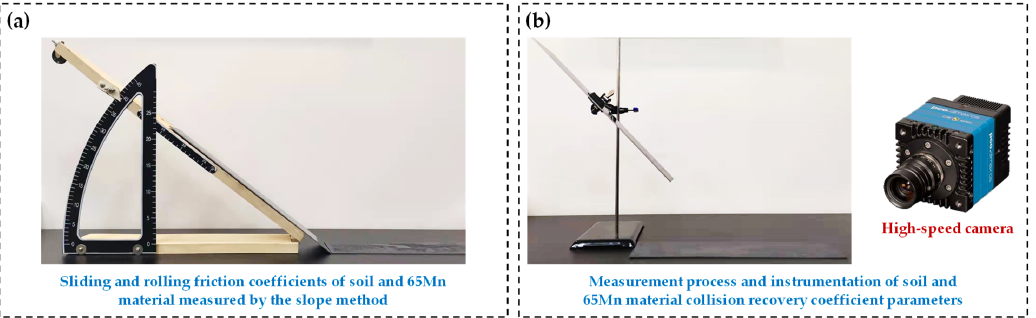
Figure 2. Measurement process and equipment for measuring contact parameters of black soil and 65 Mn. ( a ) Measurement process and equipment for measuring rolling friction coefficient of black soil and 65 Mn material. ( b ) Measurement process and equipment for measuring collision recovery coefficient of black soil and 65 Mn material.